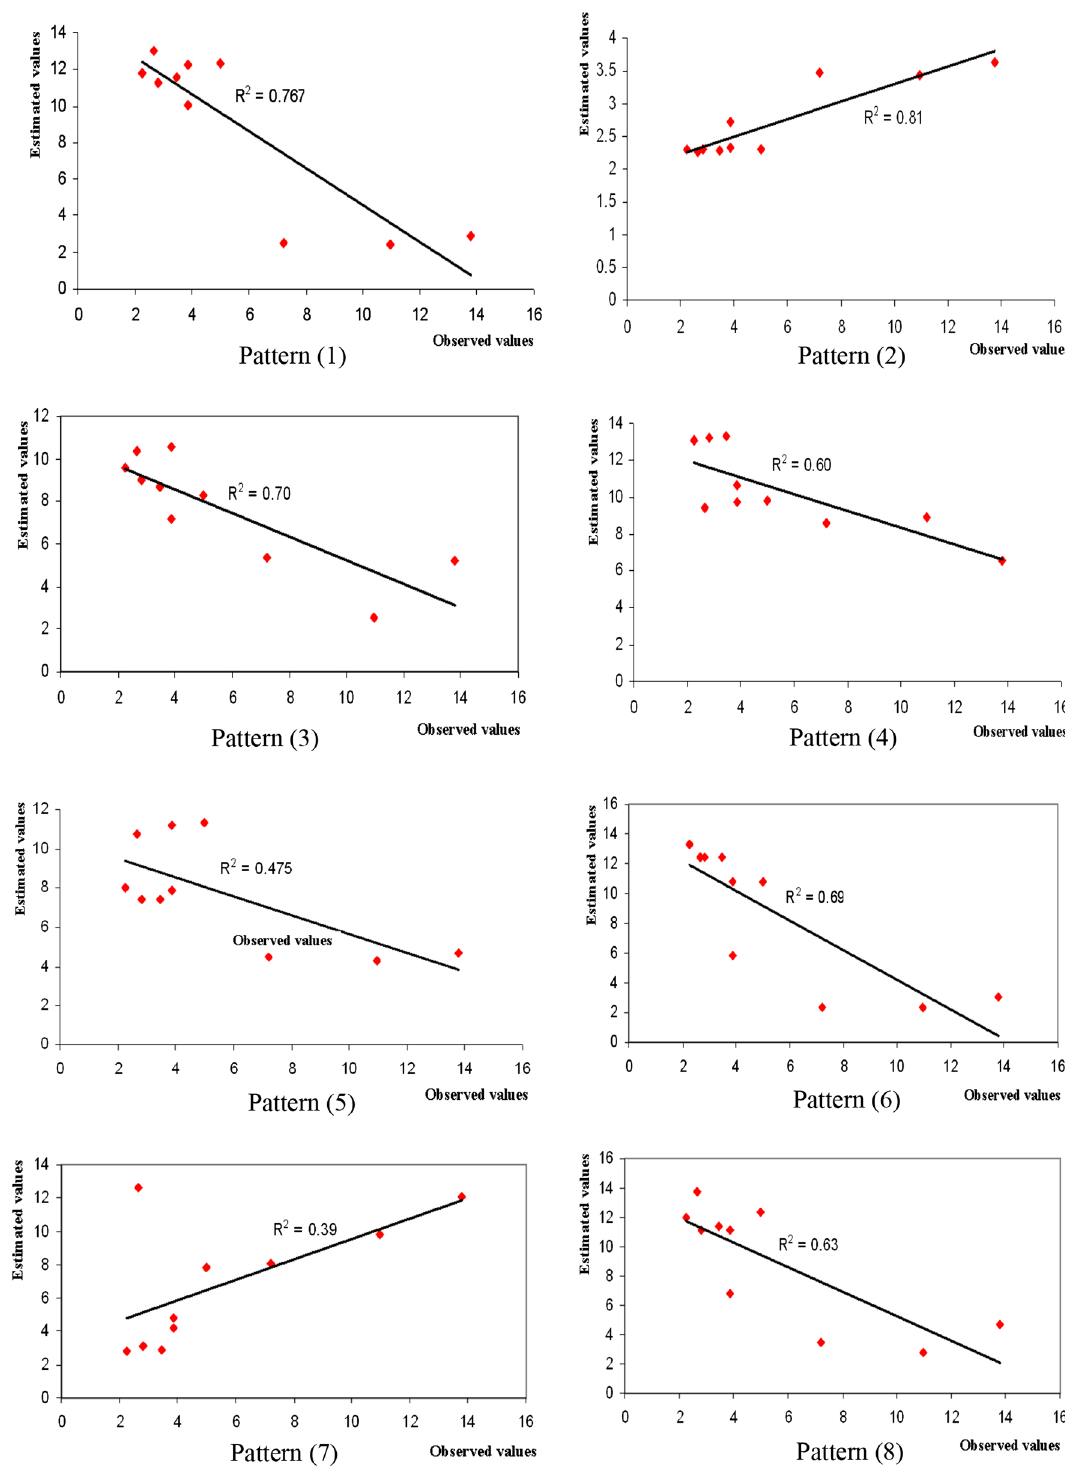
Fig. 5 Comparison between the estimated and observed values of the karst springs discharge in the different network